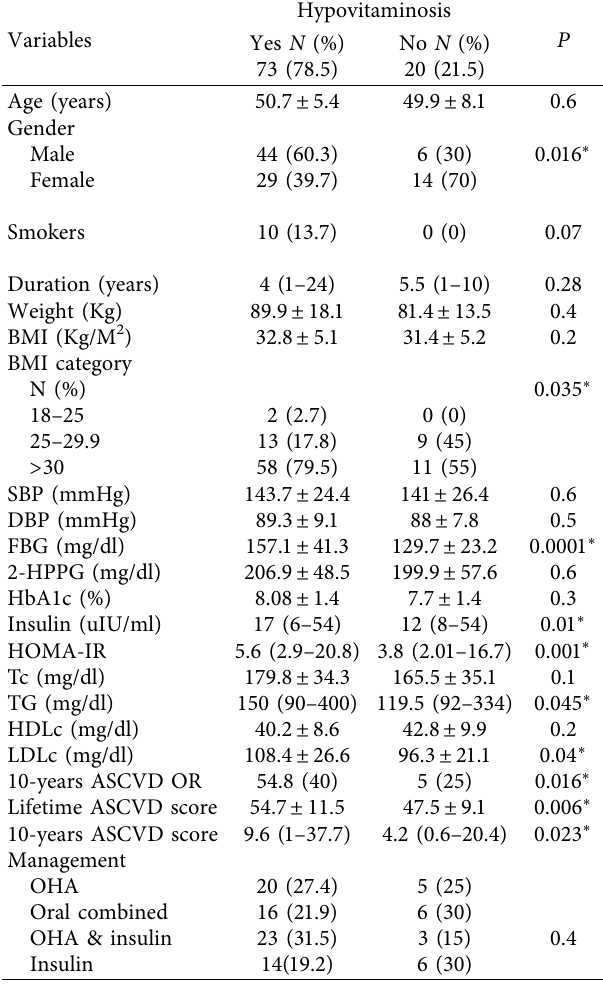
10 years of ASCVD risk as compared to those with a suf- ficient level ( P � 0 . 012) Table 3.